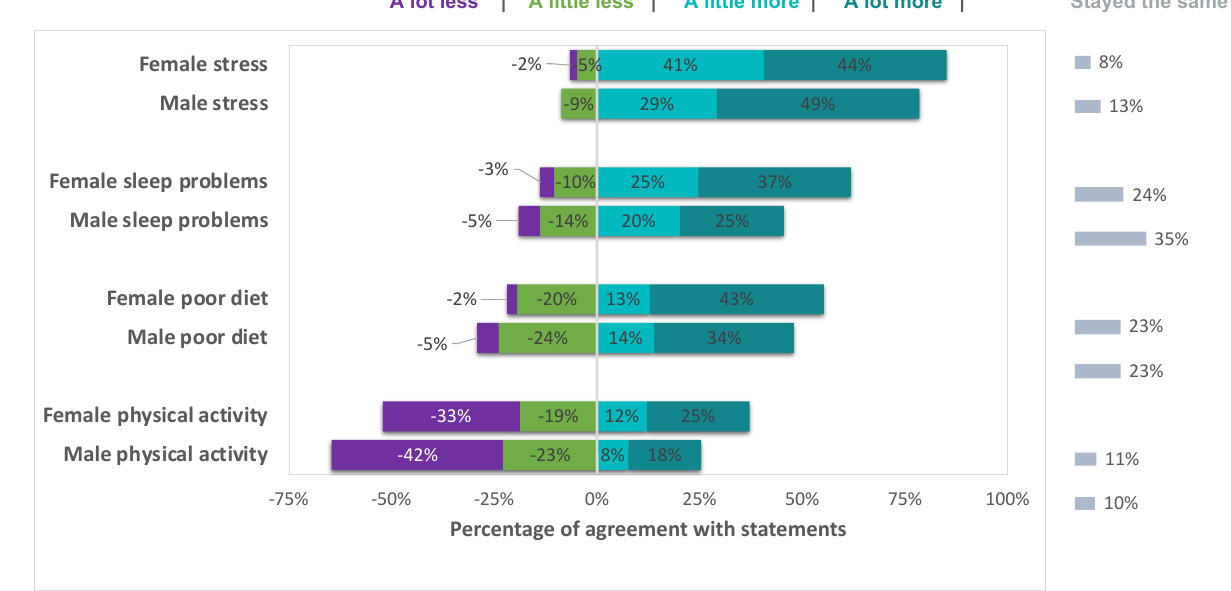
Figure 2. Change in mental wellbeing and health behaviour. Percentages represent participants’ agreement with question statements (see Section 2.3.1 for statement wording).